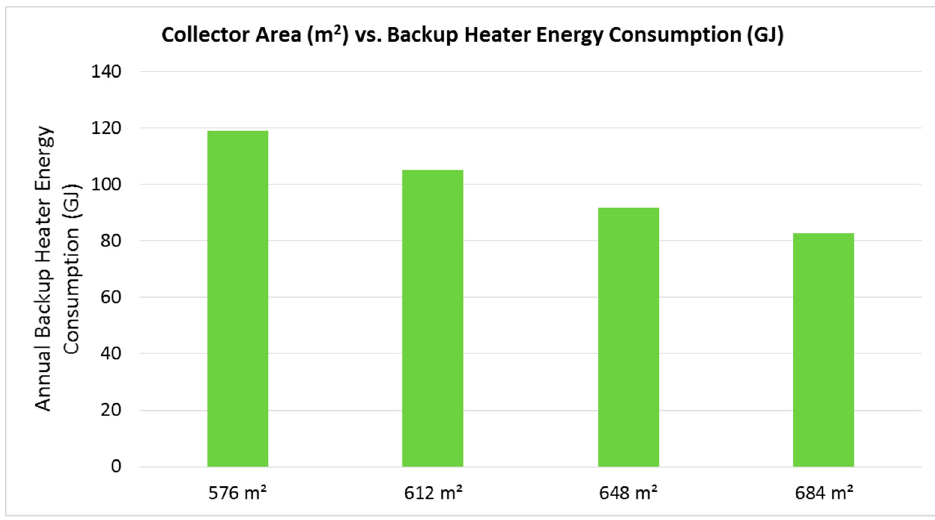
Figure 11. The impact of the solar collector area on annual backup heater energy consumption.